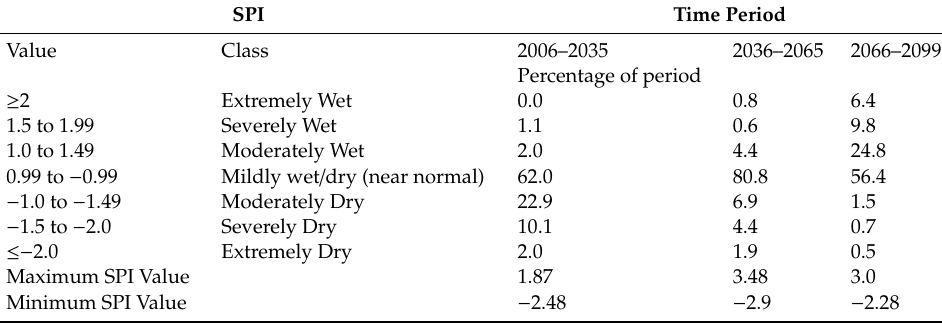
Table 10. Percentage variation of SPI values for Agoro over the period